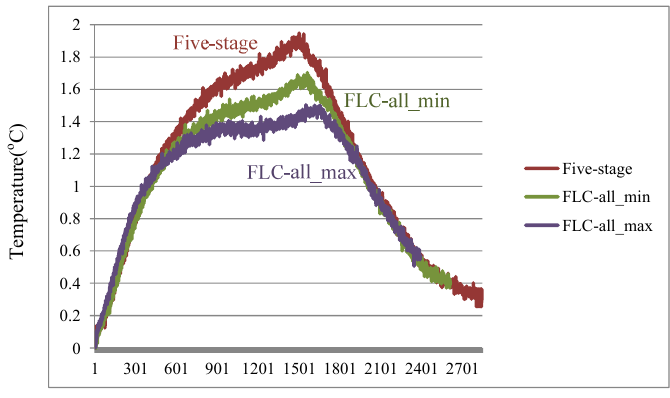
Figure 10. Temperature rise of the five-stage CC charging algorithm and the proposed FLC-based charging algorithm.